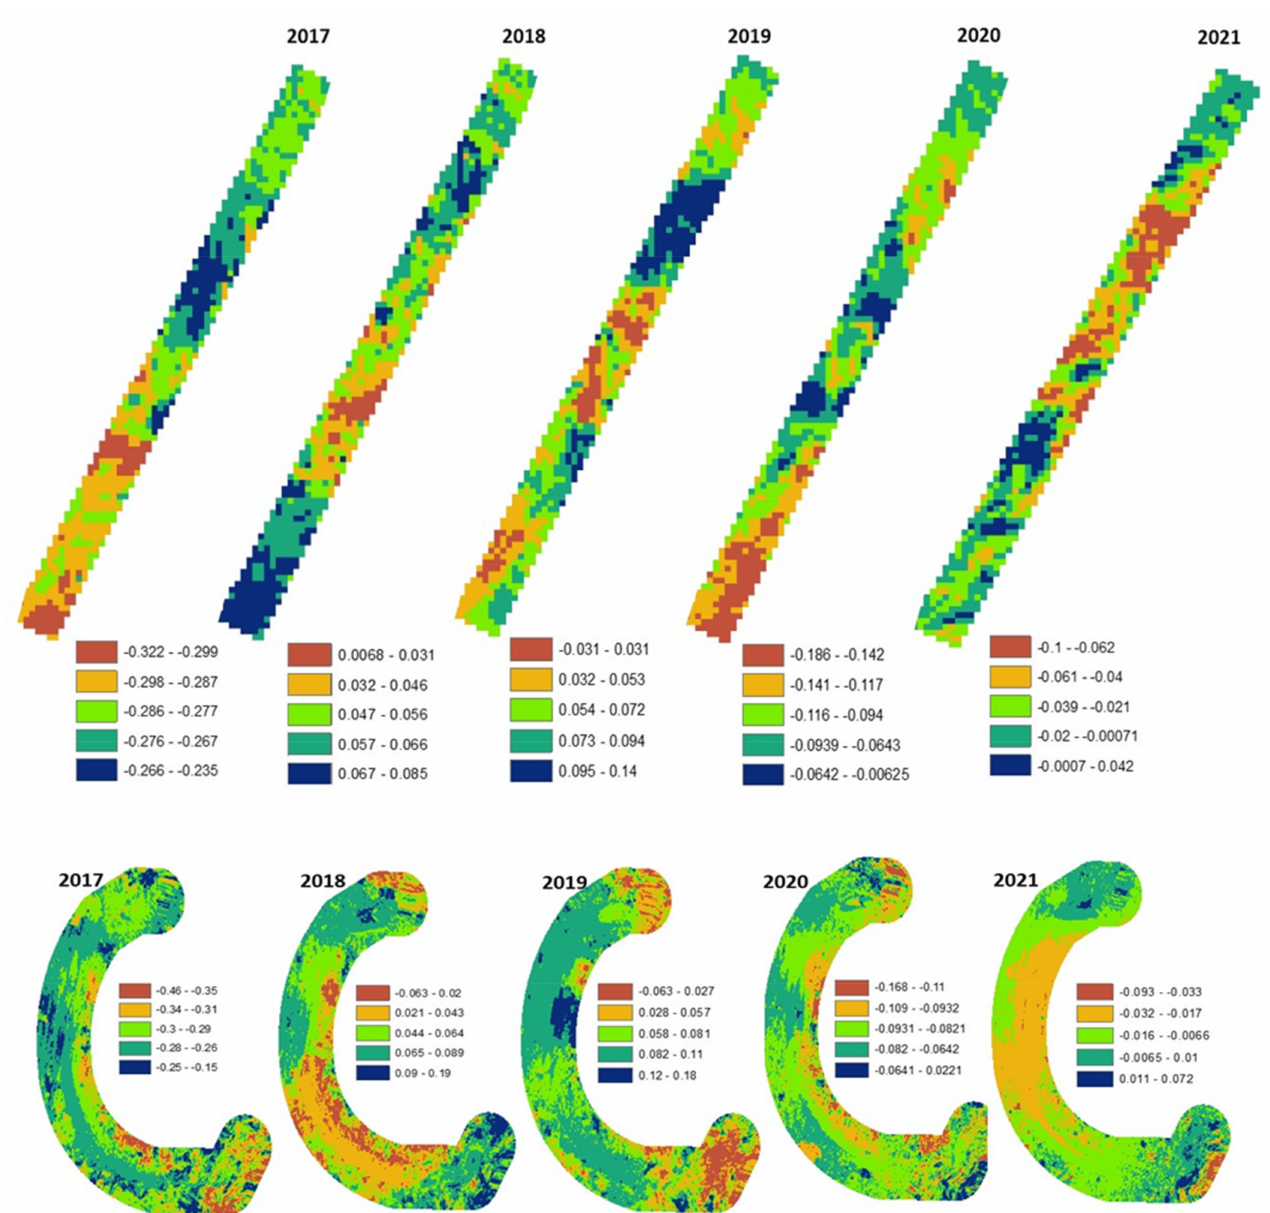
Figure 13. Annual accumulated vertical displacements from 2017 till 2021 over the GERD’s Main Dam ( Top ) and Saddle Dam ( Bottom